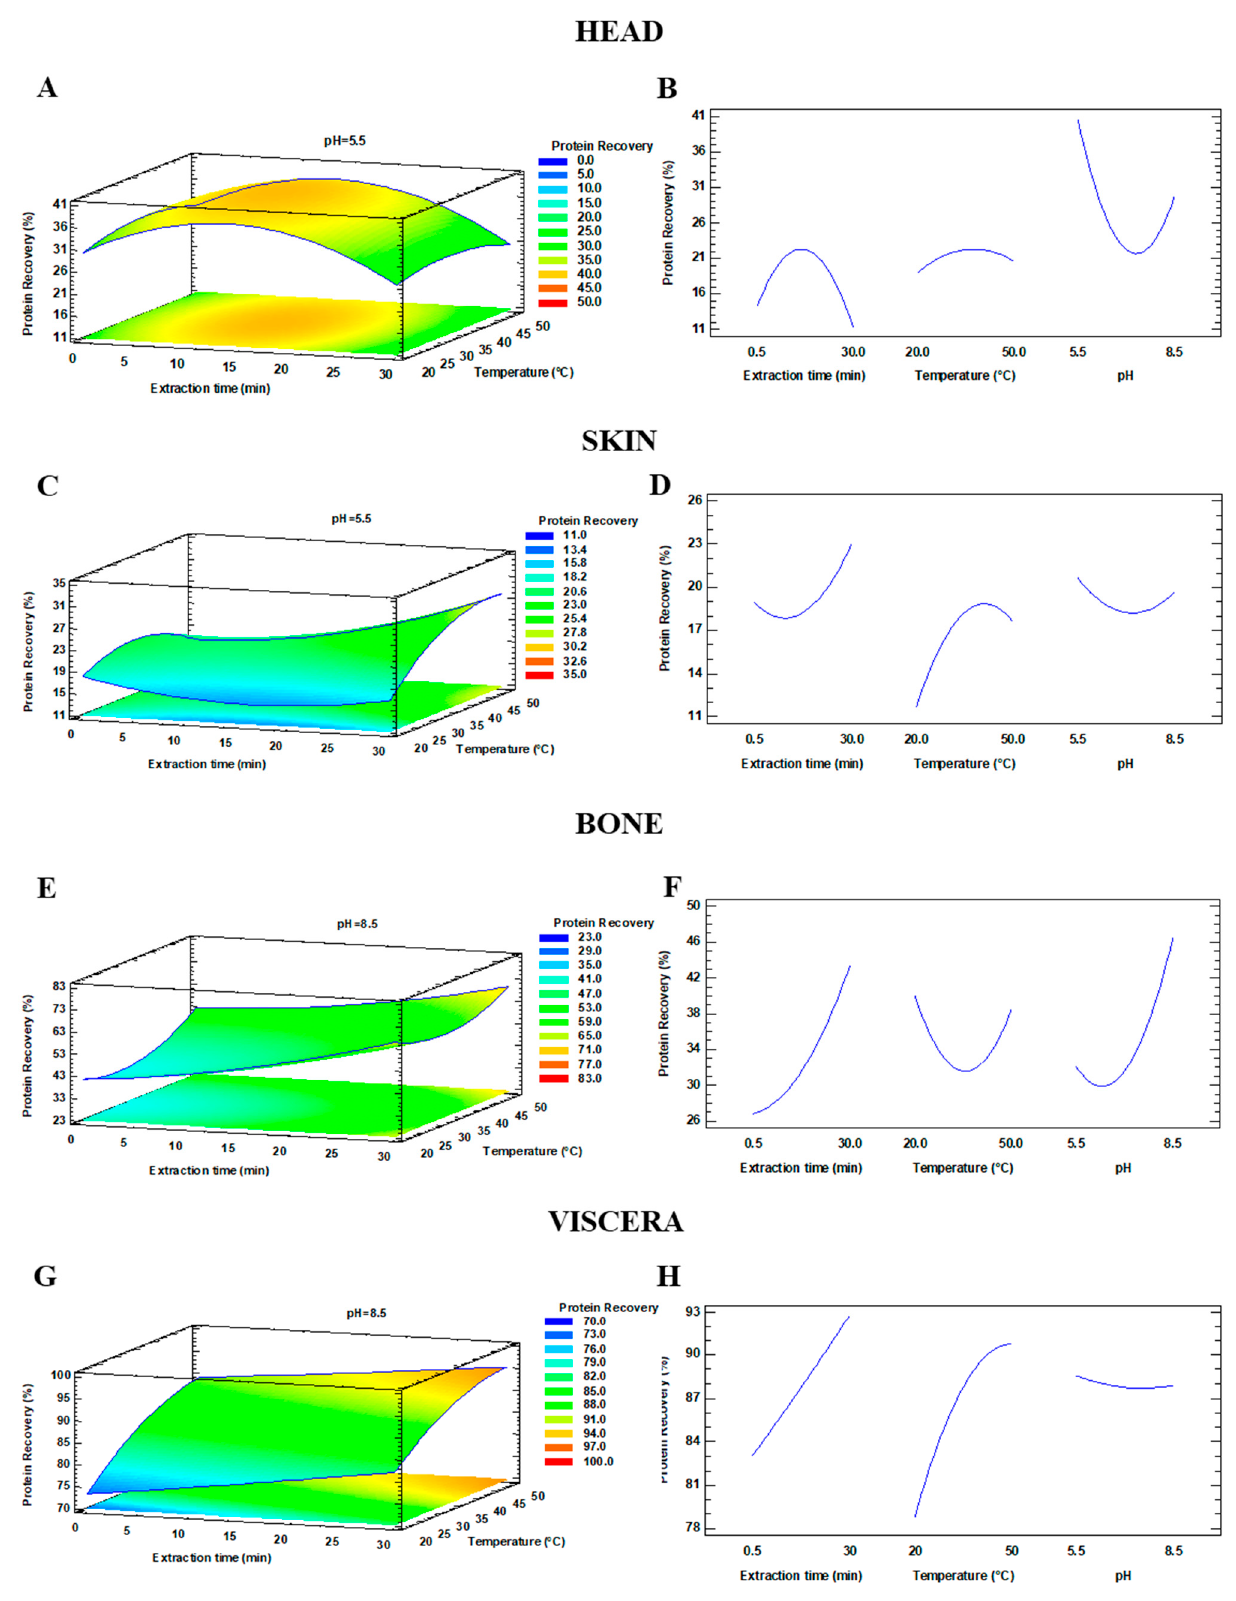
Figure 2. Plots shown in ( A , C , E , G ) indicate the response surface plot for the percentage of recovered protein as a function of the extraction time (min) and temperature (°C) at fixed pH. The plots in ( B , D , F , H ) show the influence of the different parameters (extraction time, temperature, and pH) on the recovery of protein (%) from sea bass side streams.